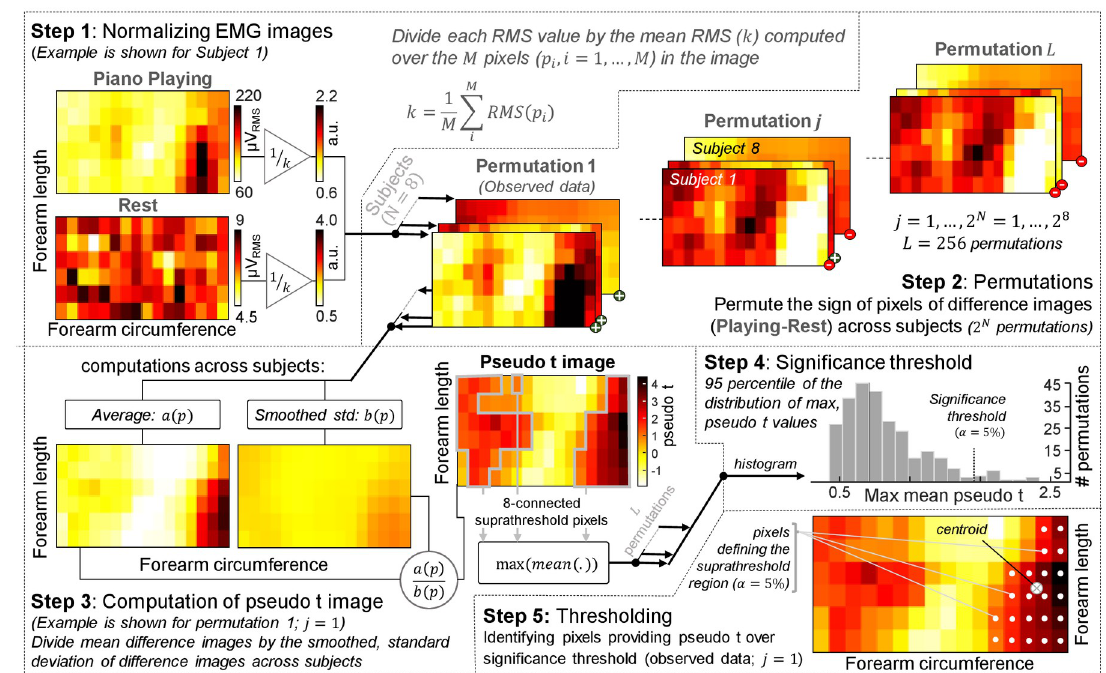
Fig 3. Statistical assessment of consistent excitation across subjects. This figure systematically illustrates the procedures necessary for applying the statistical, permutation test described by Nichols et al. [23] to EMG images. The method is spited into five steps, detailed in the text and summarized in insets. In all images illustrated, higher and lower values are represented with respectively darker and brighter pixels. The example is shown for the improvisation